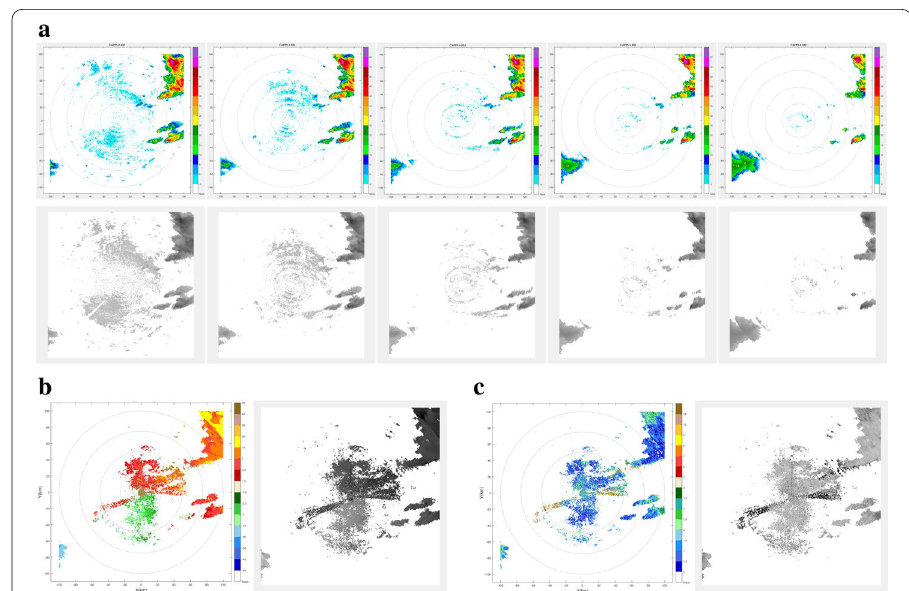
Fig. 12 The pre-processed radar data corresponding to 2342UTC, a CAPPI distribution map of the reflectivity at 2–6 km altitudes, b Radial velocity distribution map of the ground horizontal wind field, c Spectral width data distribution map of the ground horizontal wind field